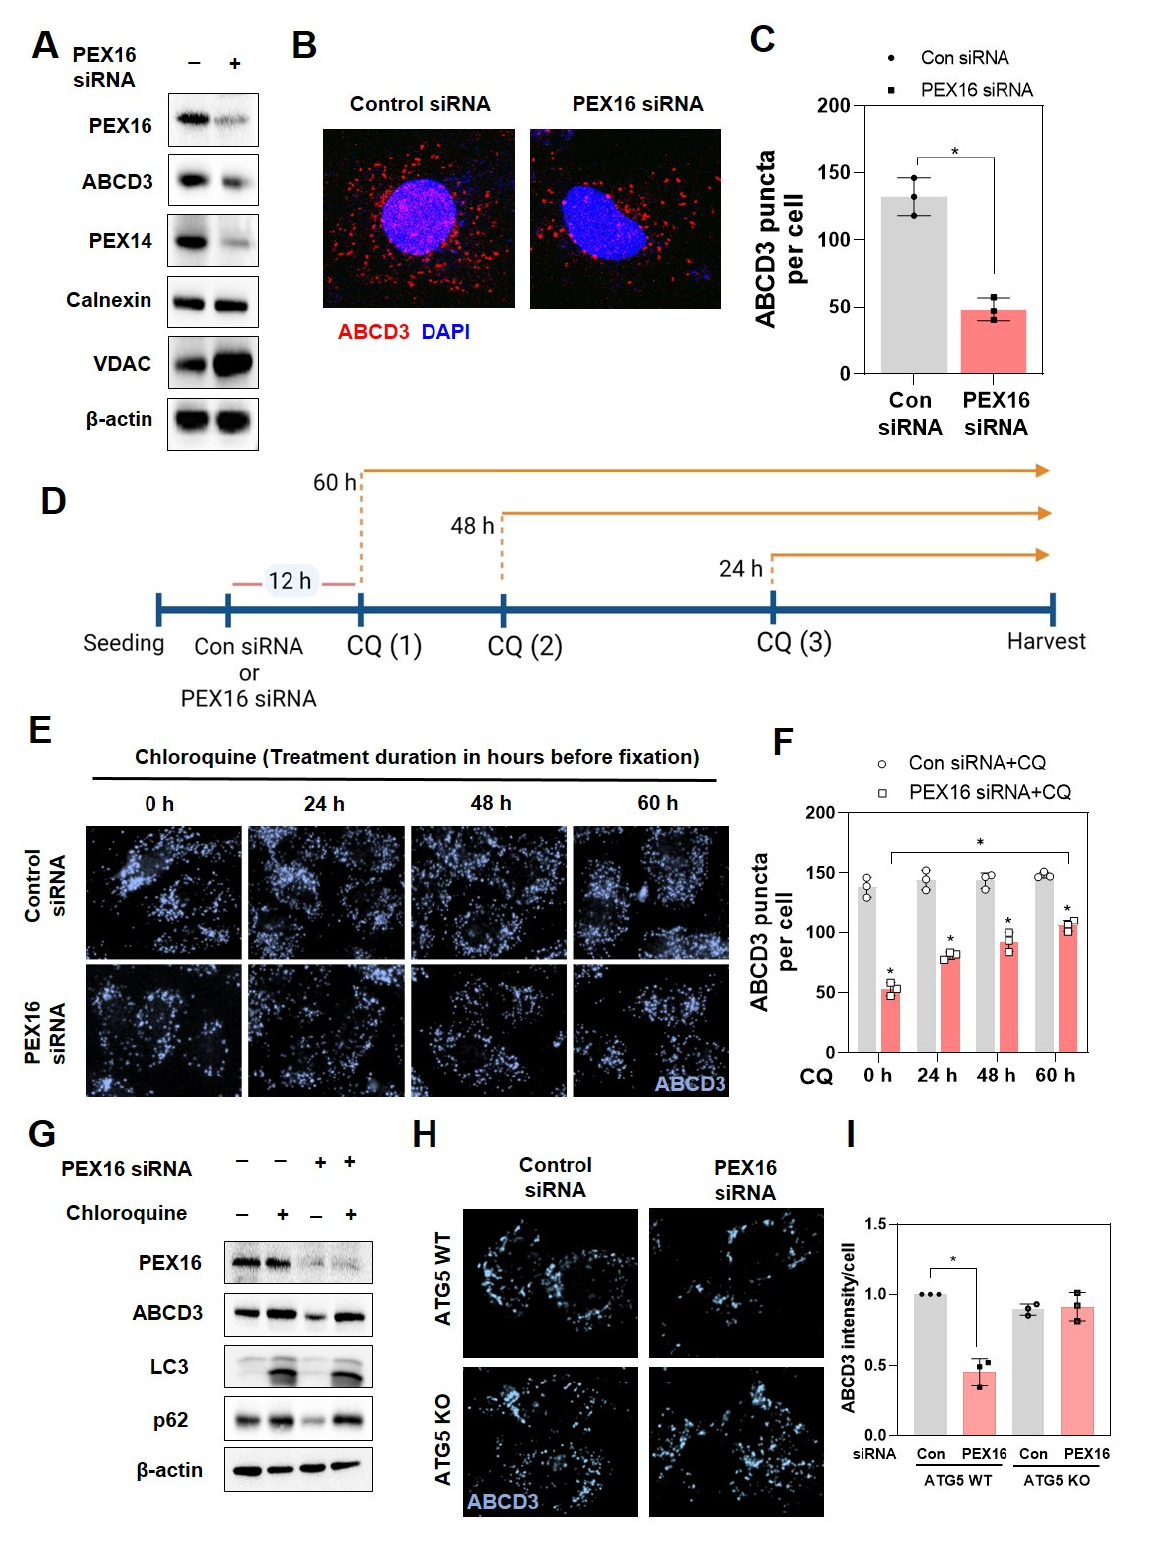
Figure 2. Pexophagy mediates the loss of peroxisomes in RPE-1 cells with PEX16 knockdown. ( A ) Western blot analysis was used on RPE-1 cell lysates to check the protein expression of PEX16, ABCD3, PEX14, Calnexin, and VDAC, using β -actin as an internal control. ( B ) Cells were treated with PEX16 siRNA for 72 h, immunostained with ABCD3, and ( C ) the number of peroxisomes per cell was quantified. Data are expressed as means ± S.D. ( n = 3, independent experiments), * p < 0.05. ( D ) Cells were transfected with PEX16 siRNA, and then treated with chloroquine (CQ) at different time intervals as indicated. ( E ) Then, cells were subjected to immunofluorescence with ABCD3 antibody. ( F ) The number of ABCD3 puncta per cell was quantified. All data are presented as means ± S.D. ( n = 3, independent experiments), * p < 0.05. ( G )